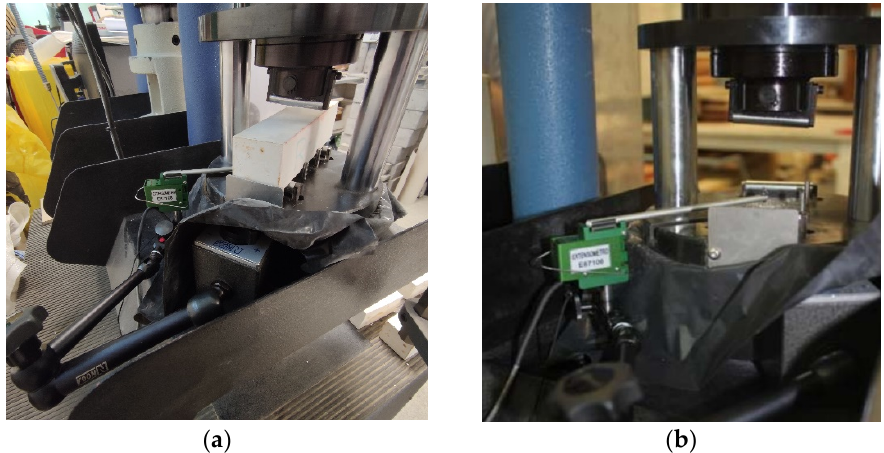
Figure 2. Strain gauge for measuring the deflection. Instrument calibration ( a ) and use with test pieces ( b ).